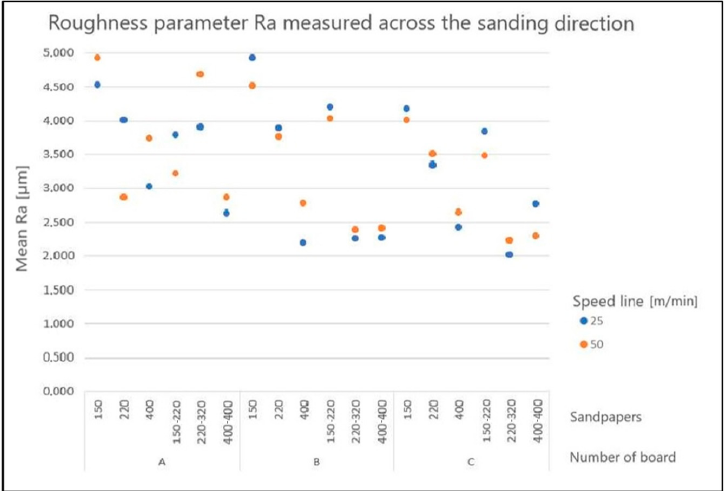
Figure 5. Structure of arithmetic mean deviation Ra in the transverse direction, depending on the sanding program.